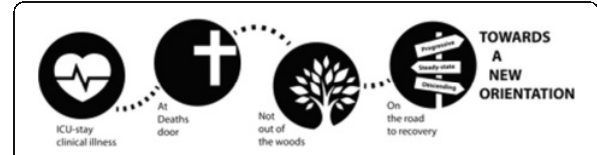
Fig. 21 (abstract A36). Basic illness narrative across three